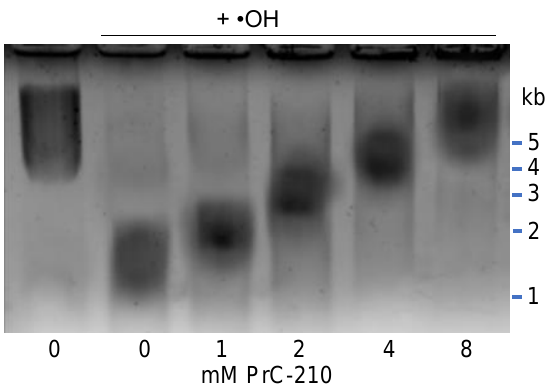
Figure 7. Suppression of hydroxyl radical-induced rat kidney mitochondrial DNA fragmentation by PrC-210 in a dose-dependent manner. Ten minutes before addition of the hydroxyl radical generator, PrC-210 was added to the incubations at the indicated concentrations. Following 20 min incubation at 37 °C, a reaction aliquot (10 µL) was mixed with 0.1% SDS loading dye and heated to 60 °C (1 min). Electrophoresis was performed, and gels were stained with ethidium bromide.